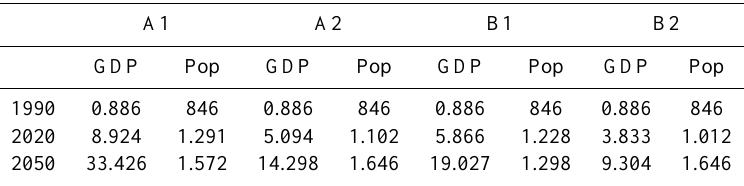
Table 4. Scenarios are based upon the work carried out by TERI (India) showing the projected GDP and Population outcomes for all India based upon the SRES scenarios (GDP × 1013 Rupees, Population in millions).